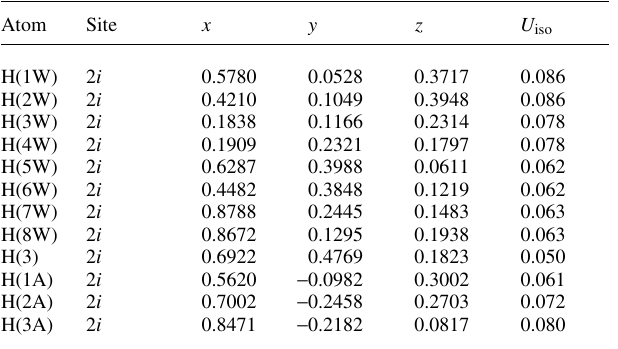
Table 2. Atomic coordinates and displacement parameters (in Å 2 ) .